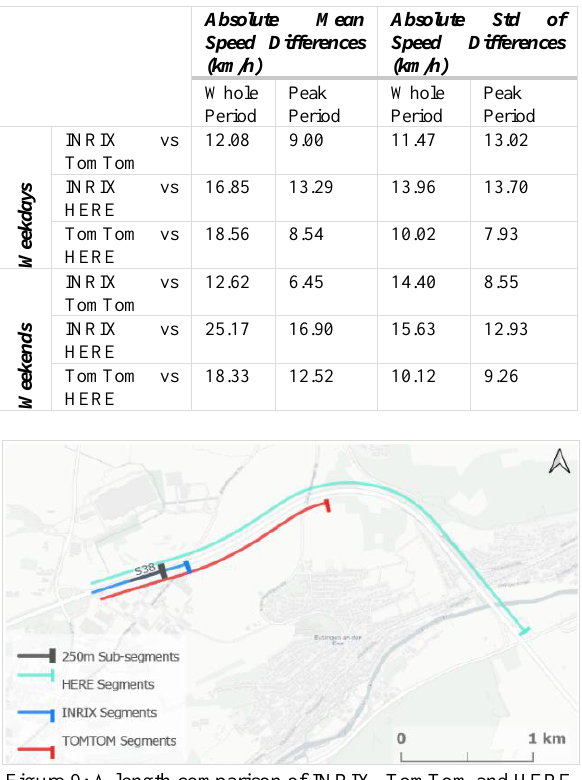
Figure 9: A length comparison of INRIX, TomTom and HERE segments with the virtual sub-segment